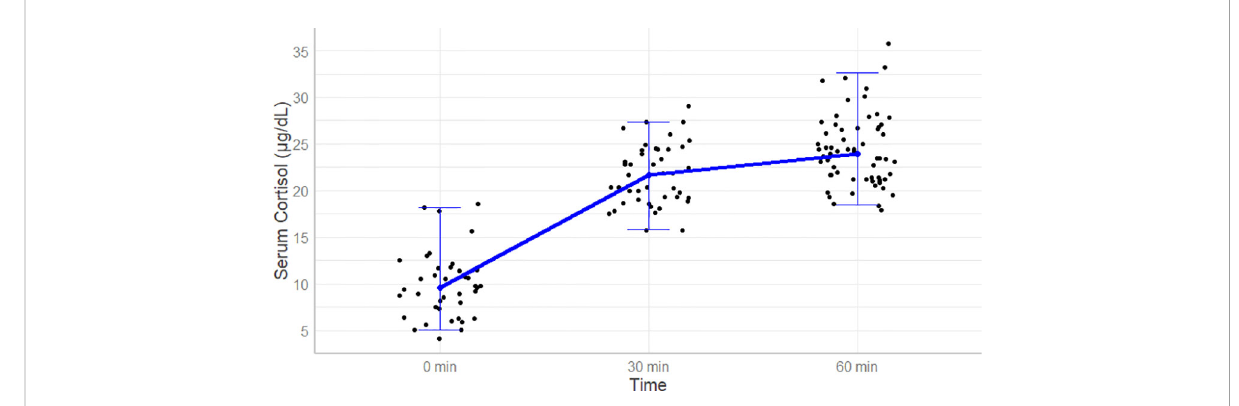
FIGURE 2 Cortisol levels at baseline and then 30 and 60 minutes after the Standard Dose Cosyntropin Test. The solid line connects the median values. The whiskers represent 95% of the